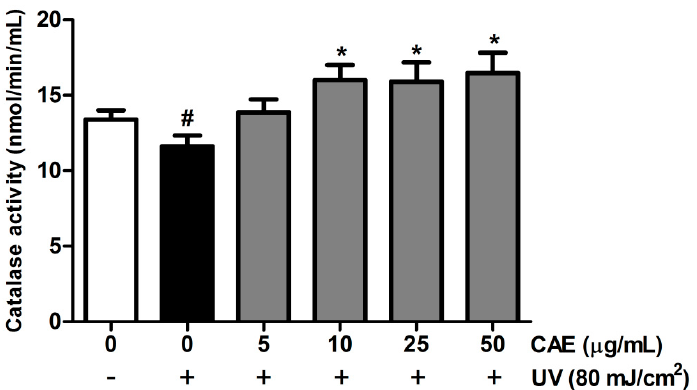
Figure 7. Effects of CAE on CAT activity in human skin fibroblasts. UVB irradiation inhibited CAT activity, whereas CAE treatment reversed the effect. Significant difference versus control: #, p < 0.05; significant difference versus the UVB-induced group: *, p < 0.05.